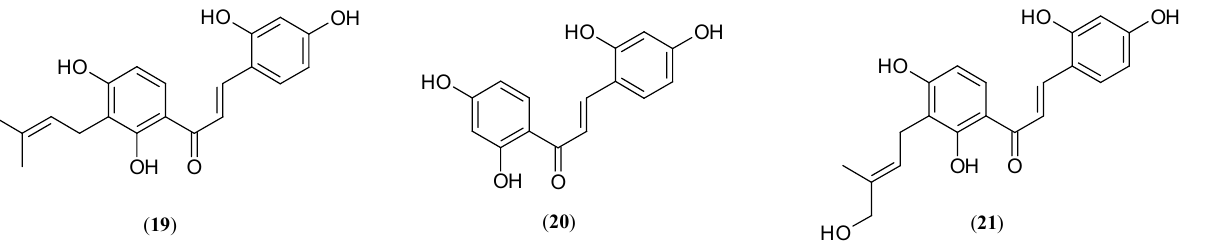
Figure 5. Structures of chalcones: morachalcone A ( 19 ), 2,4,2′,4′-tetrahydroxychalcone ( 20 ), 3′-[(E)-4″-hydroxymethyl-2″-butenyl]-2,4,2′,4′-tetrahydroxychalcone ( 21 ) with tyrosinase inhibitory activity isolated from genus Morus .